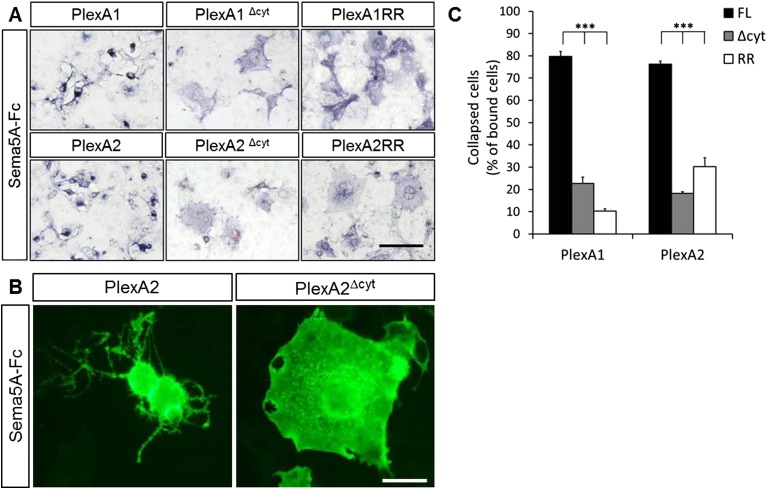
Sema5A-Fc–induced collapse of PlexA1- and PlexA2- expressing COS7 cells requires PlexA rasGAP activity.(A) COS7 cells were transiently transfected to express full-length (FL) PlexA1, PlexA2, deletion mutants lacking their cytoplasmic domains (PlexA1Δcyt, PlexA2Δcyt), or point mutants selectively deficient for the rasGAP activity (PlexA1RR and PlexA2RR) that resides in the PlexA cytoplasmic portion. Cells were then incubated with Sema5A-Fc oligomerized with anti-Fc conjugated to placental alkaline phosphatase. Sema5A-Fc induces collapse of PlexA1- and PlexA2-expressing COS7 cells. Deletion of the PlexA1 or PlexA2 cytoplasmic domain, or mutation of the rasGAP activity in either plexin, does not impair binding of Sema5A-Fc but attenuates COS7 cell collapse. (B) All PlexA constructs contain an N-terminal myc-tag. High magnification anti-myc labeling of PlexA2 and PlexA2Δcyt transfected cells treated with Sema5A-Fc. Immunolabeling was carried out under non-permeable conditions. (C) Quantification of the percentile of Sema5A-Fc binding cells that show a collapsed morphology. Values are represented as mean ± SEM from three independent experiments. p value ***p < 0.0001, two-tailed unpaired Student's t test. Scale bar = 50 μm.